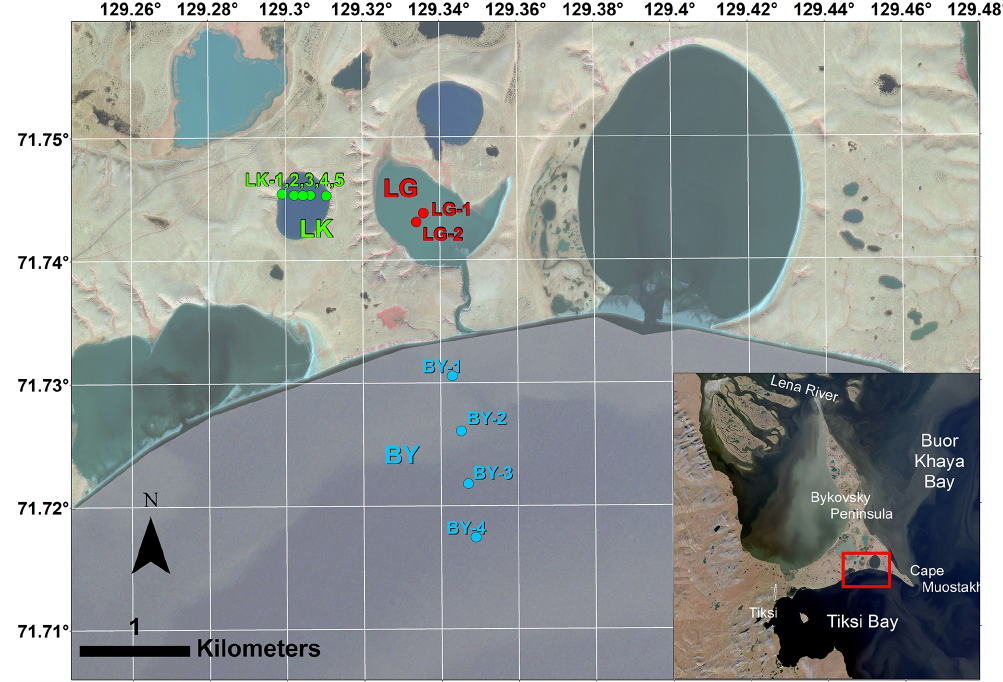
Figure 1. Study design on the Bykovsky Peninsula, NE Yakutia, Arctic Russia. Ice cores were recovered from three water bodies on the southern shore of the Bykovsky Peninsula: Tiksi Bay (BY: blue), Polar Fox Lagoon (LG: red) and Goltsovoye Lake (LK: green dots). Imagery in the main map is from WorldView-3 on 2 September 2016 (© DigitalGlobe). Table 1. Hydrological characteristics of water bodies of the southern Bykovsky Peninsula from which ice cores were taken for this study in spring 2017. Water temperatures and electrical conductivity for LG and LK were measured in the field below the ice; temperature and salinity for BY are from Charkin et al. (2017). Diameter Max depth Water temp. Elec. cond. Salinity Number of Mean